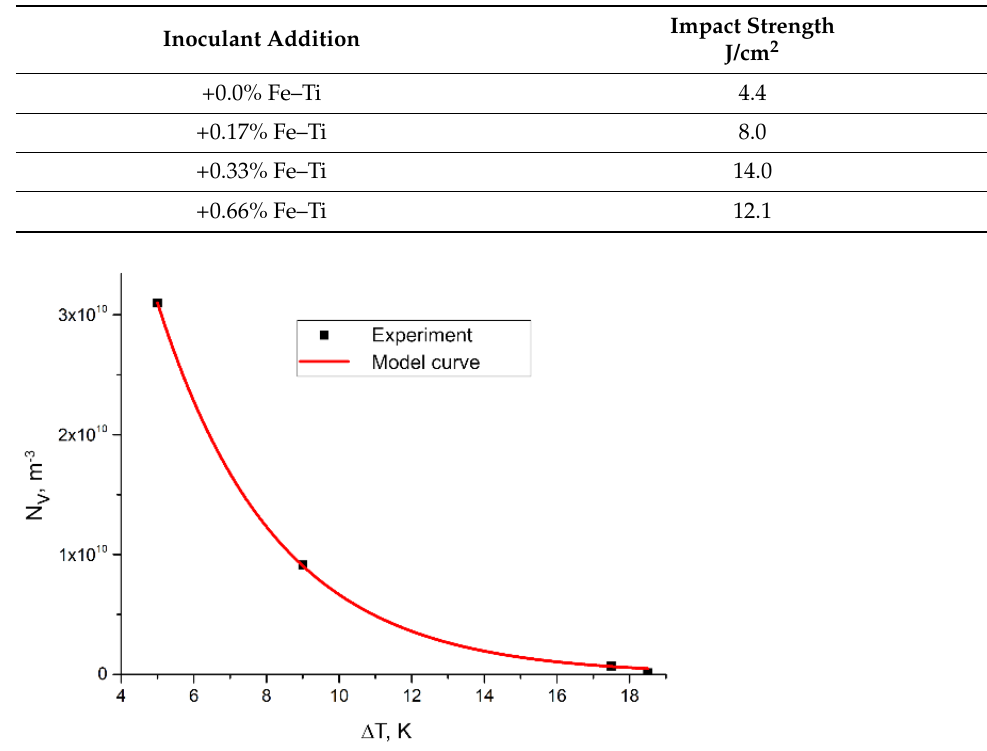
Figure 14. Influence of maximum degree of supercooling ∆ T on austenite grain density—the results of experiment and model curve calculated from (5).